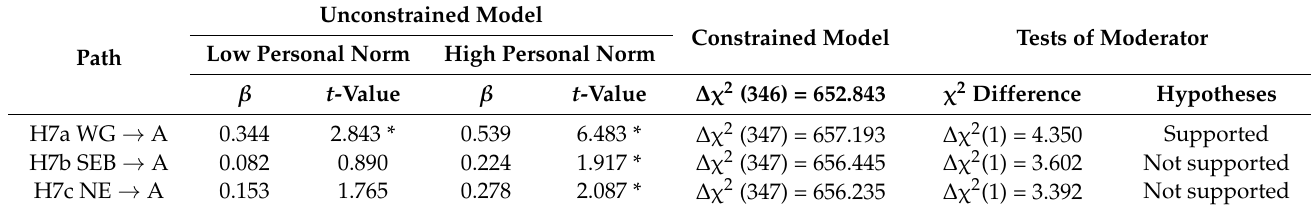
Table 4. Moderating role of personal